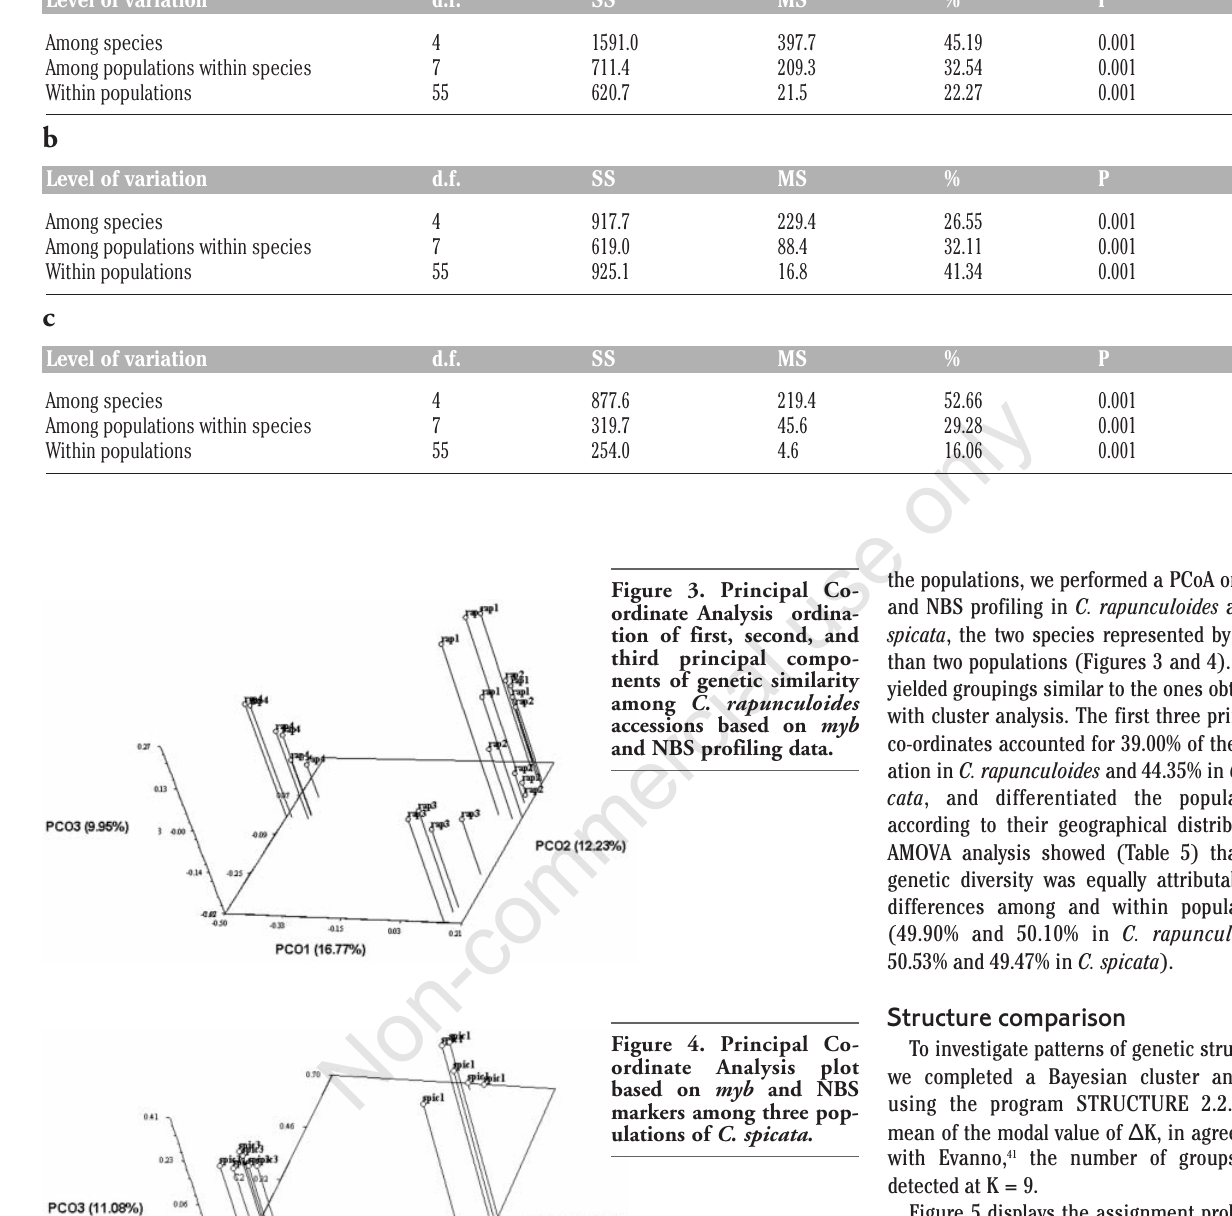
Table 4. Analysis of molecular variance among and within the five species and 12 populations of Campanula based on myb and NBS combined profiles (a) and NBS (b) and myb (c) alone. Levels of significance were based on 1000 interation steps (SS, sums of squares; MS, means squares; %, proportion of genetic variability; P-value, level of significance). a Level of variation